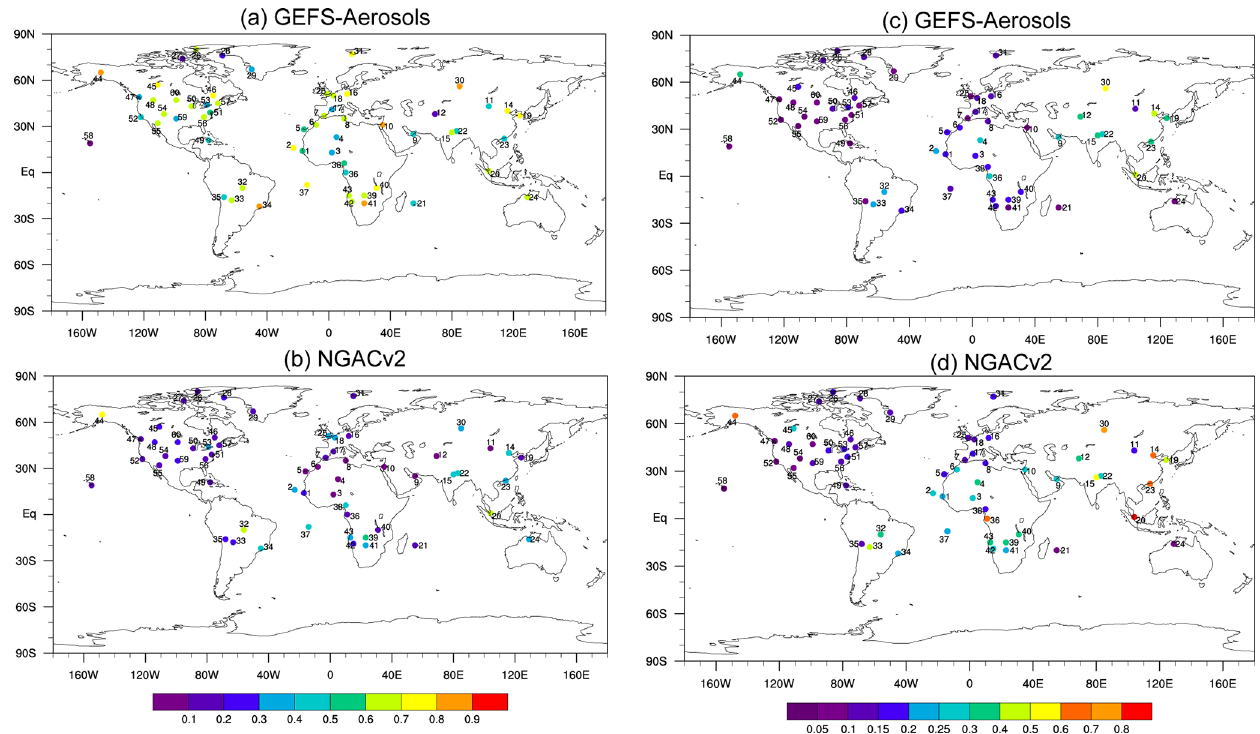
Figure 5. Correlation coefficients and RMSE between AERONET daily total AOD observations and GEFS-Aerosols, ICAP, and NGACv2 for the period 5 July–30 November 2019. Correlation coefficients are at the 95% confidence